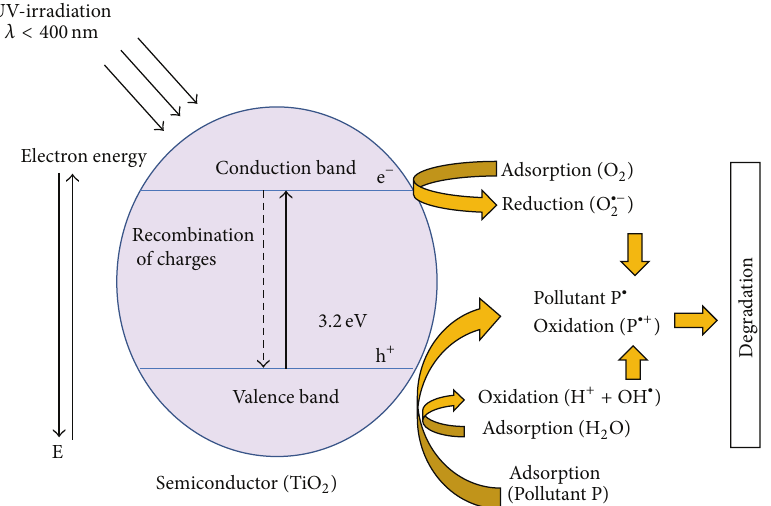
Figure 1: Activation of the TiO 2 nanocatalyst by UV